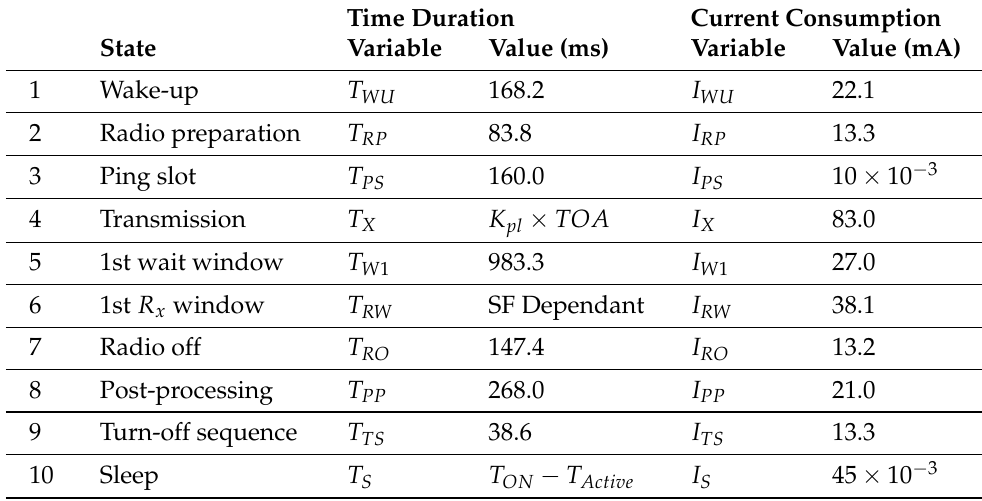
Table 2. Detailed time duration and current consumption values for the power consumption